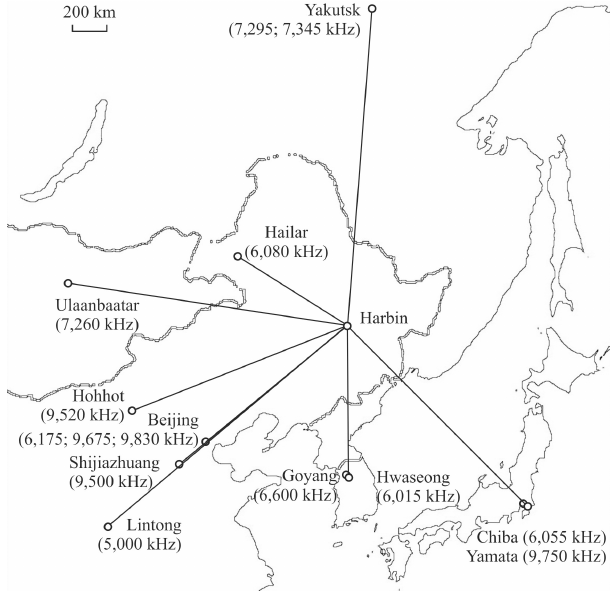
Figure 2. Schematic diagram showing the locations of the transmit- ters and the receiver (Harbin) connected by the great-circle propa- gation paths, which were used for the observation of solar eclipse